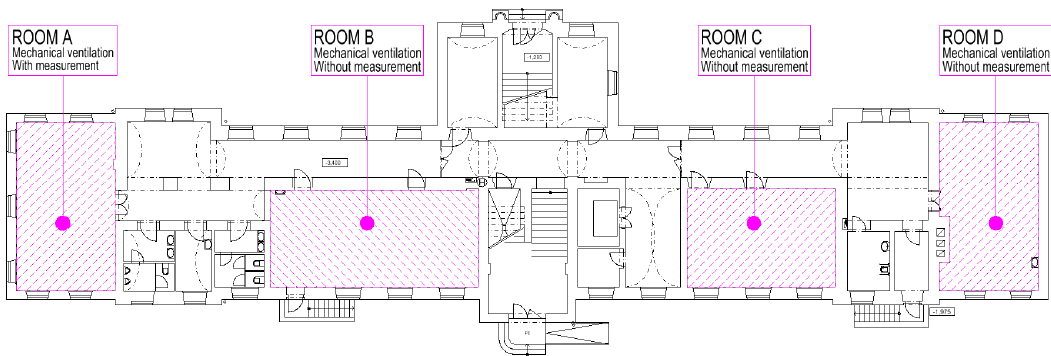
Figure 6. Plan of the basement.